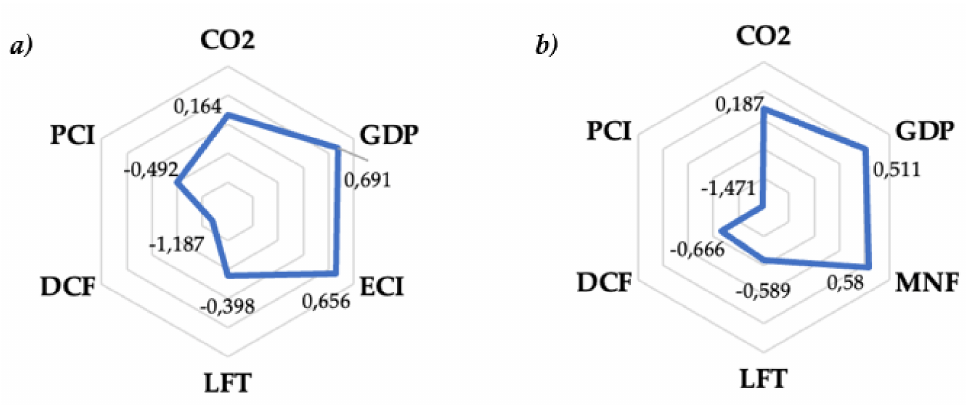
Figure 6. Results for ( a ) fixed- and ( b ) random-effects models.